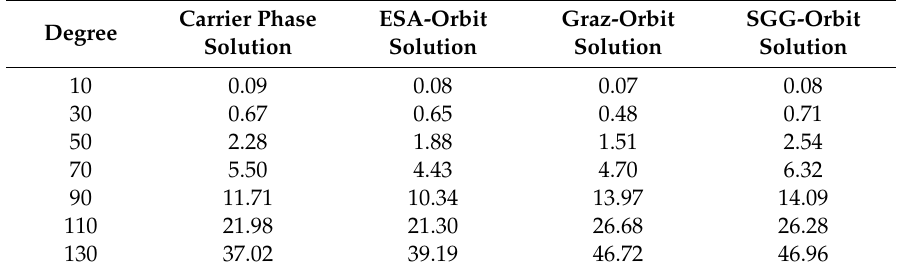
Table 5. Cumulative geoid height di ff erences (unit: cm) w.r.t. EIGEN-6C4 up to di ff erent degrees.